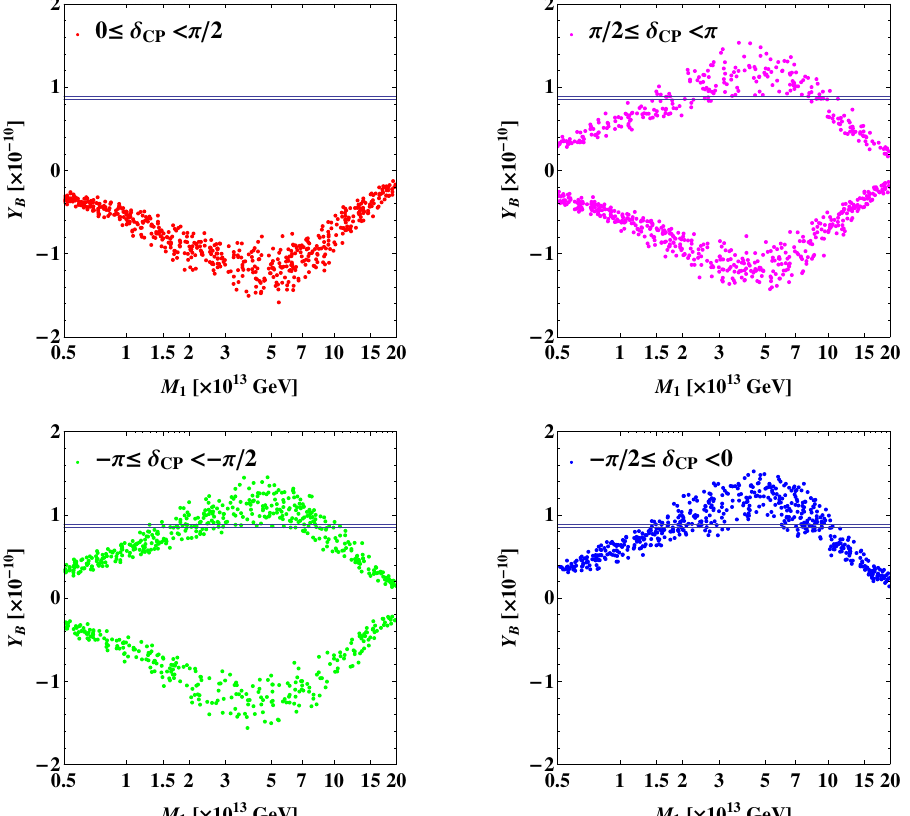
Figure 8 . The yields of the BAU in terms of the mass of the lightest right-handed neutrino for di(cid:11)erent values of (cid:14) CP . (cid:14) CP is taken in the range [0 ; (cid:25)= 2] (top-left), [ (cid:25)= 2 ; (cid:25) ] (top-right), [ (cid:0) (cid:25); (cid:0) (cid:25)= 2] (bottom-left) and [ (cid:0) (cid:25)= 2 ; 0] (bottom-right). The solid lines are upper or lower bound for the obser- vational value of Y B